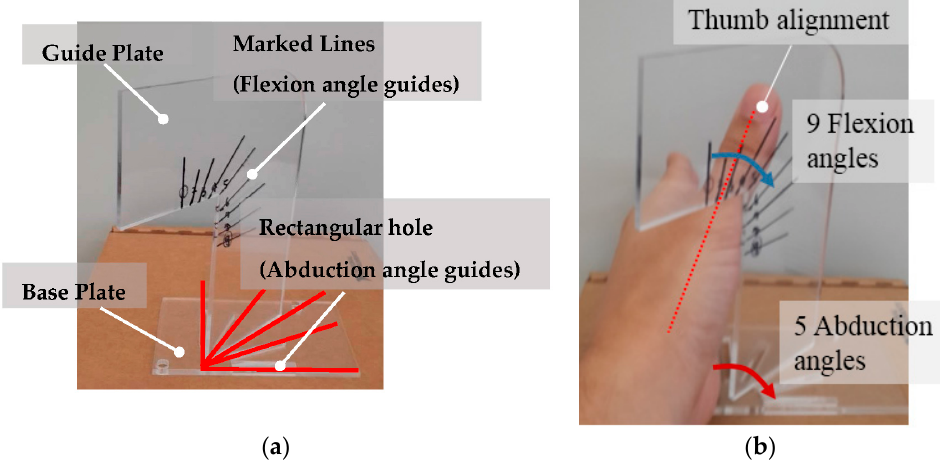
Figure 3. Thumb posture guide: ( a ) thumb posture guide overview; ( b ) thumb posing on the guide.